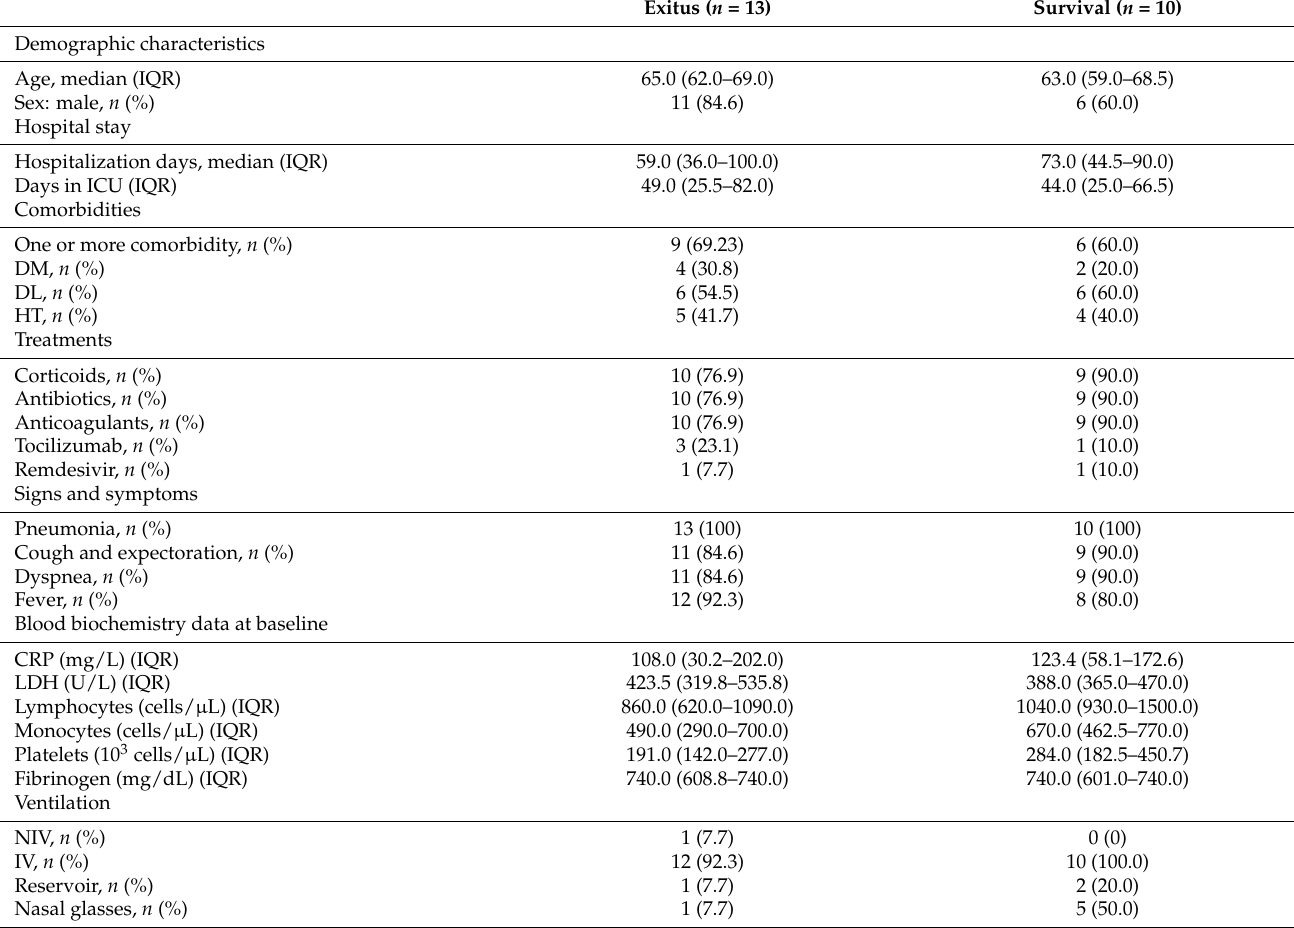
Table 1. Demographic and clinical data of all participants from the Exitus group and the Survival group who were recruited for this